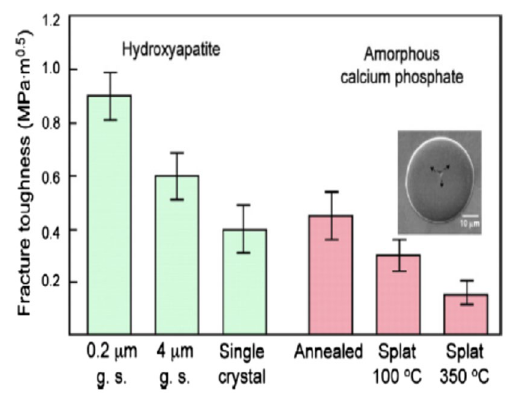
Fig. 24 a Tensile stress- strain b Compressive strength—of a scaf- fold